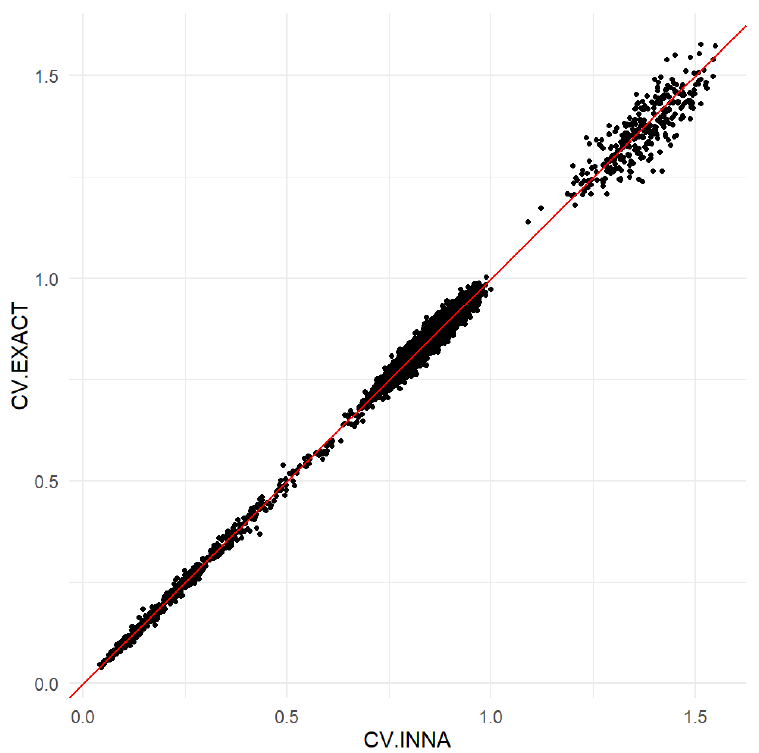
Figure 3. Comparison of the INNA method and the exact method using the CVs of the household